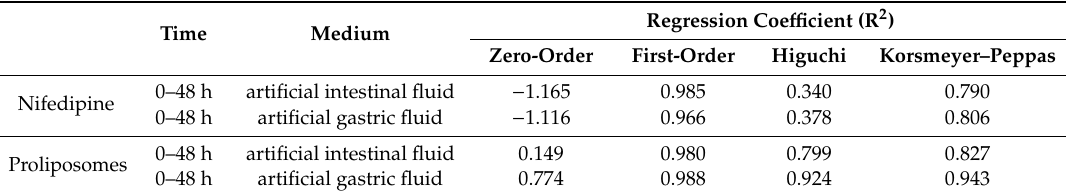
Table 3. The regression coe ffi cient of di ff erent release model of nifedipine in artificial gastric fluid and artificial intestinal